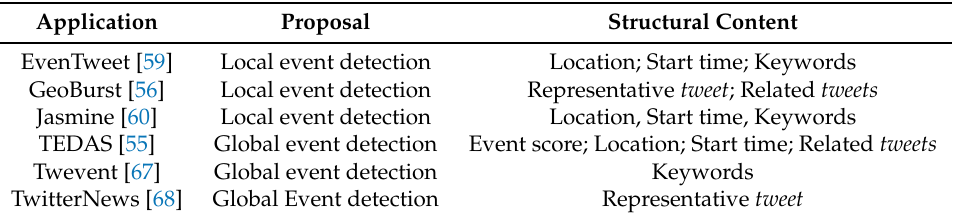
Table 1. Some unspecified Twitter on-line event detection